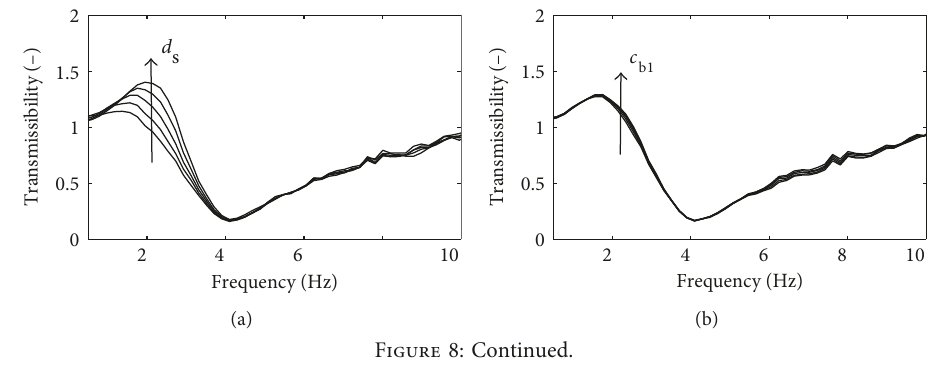
Figure 7: First-order ( ) and total effect ( ) sensitivity indices of transmissibility factor TFE WN2 x (c), and WN3 x (e); first-order ( ) and total effect ( ) sensitivity indices of suspension travel s (b), WN2 x (d), and WN3 x